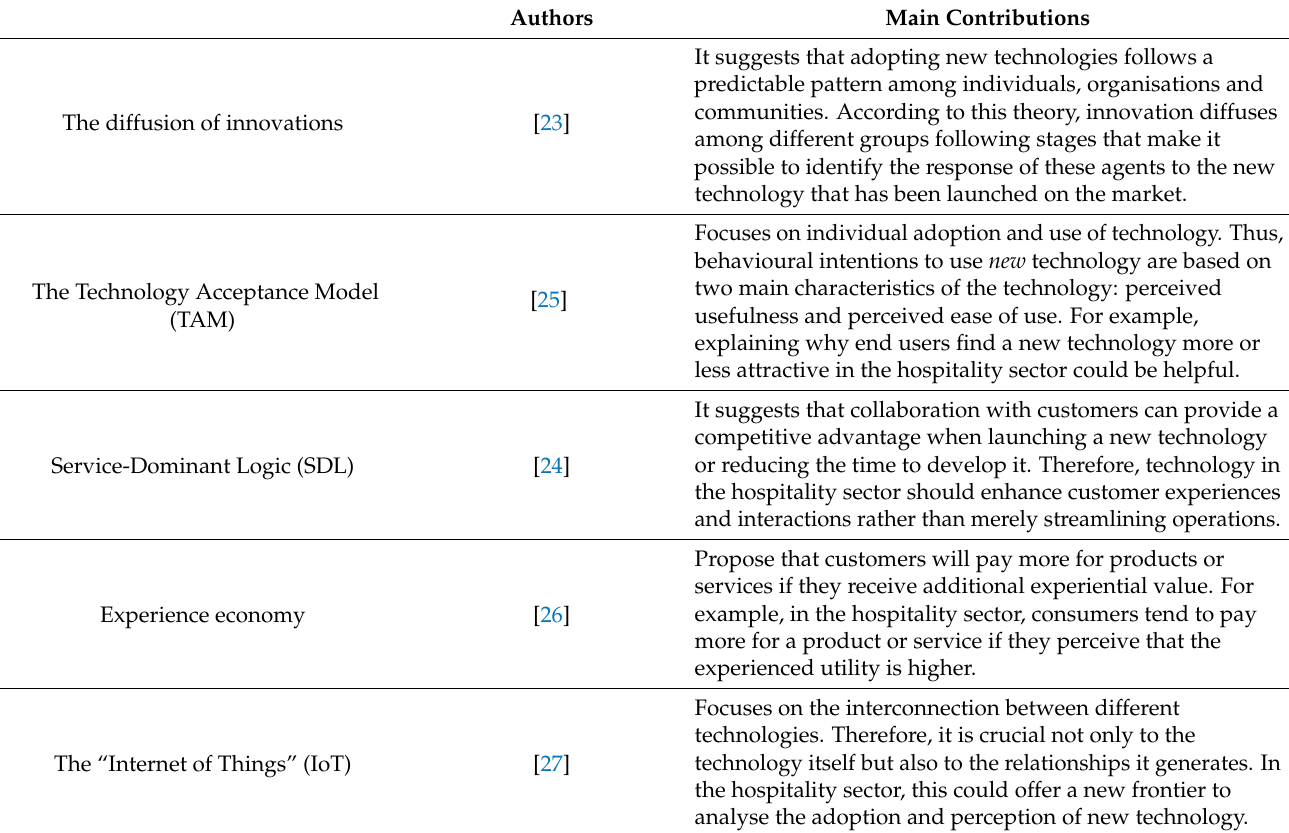
Table 1. Theories in the context of the hospitality